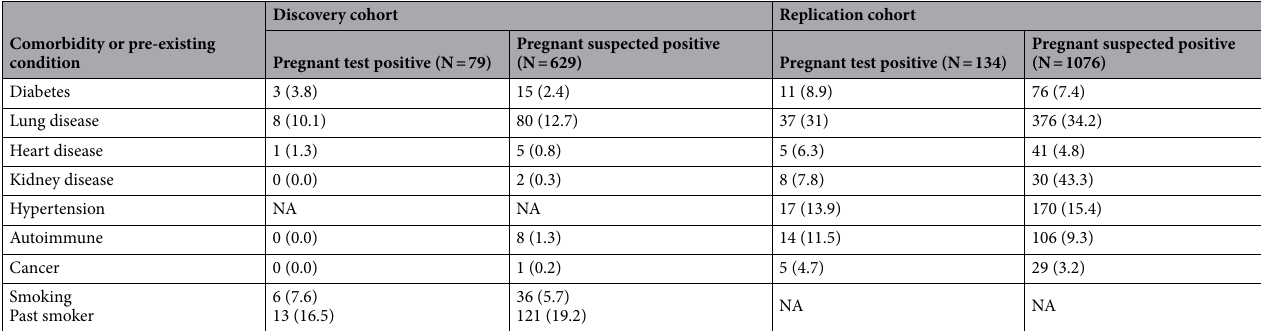
Table 3. Frequencies and percentages of comorbidities and pre-existing conditions in the discovery and replication cohorts. Columns refer to pregnant women tested and suspected positive for SARS-CoV-2 infection. Data are reported as N (%). Data from the replication cohort are reported as N surveys (survey- weight adjusted %). Conditions not ascertained or mapped in either cohort are marked as not available